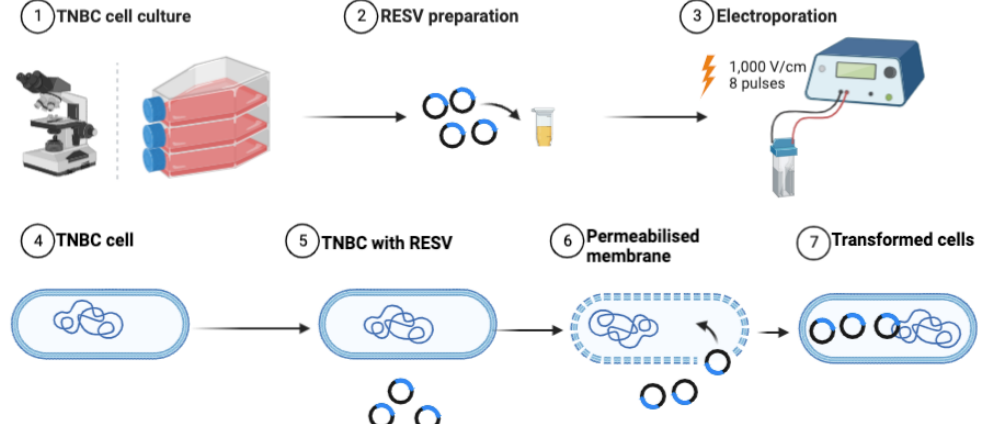
Figure 2. Experimental workflow of combinational studies illustrating the enhancement of RESV delivery induced into the TNBC cells ROS